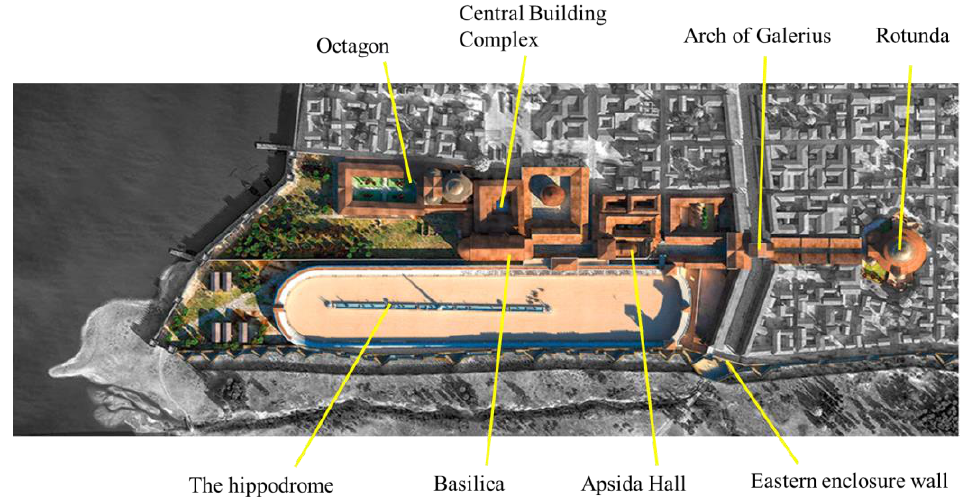
Figure 2. The Galerian Complex